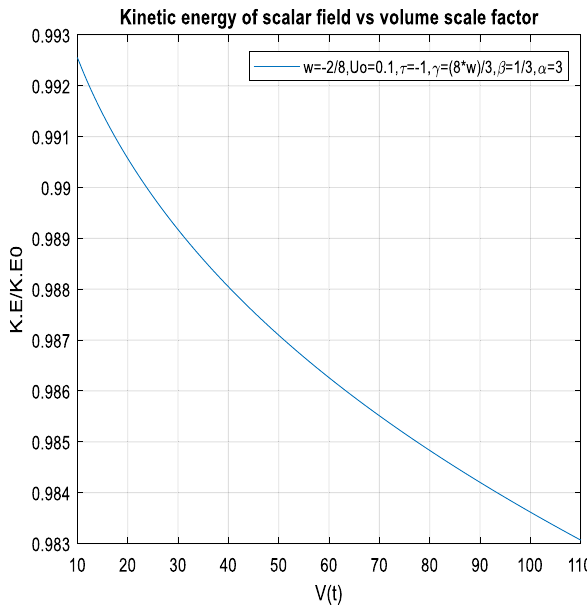
Fig. 26 Graph for kinetic term in fields; w = − 2 − 1 ; γ = 8 w